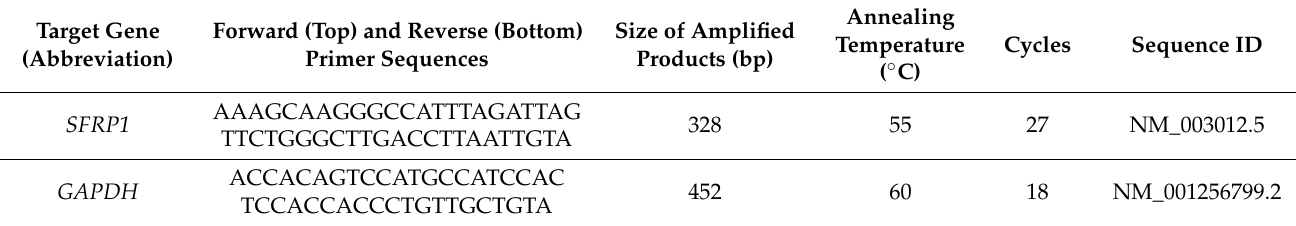
Table 1. Specific primer sequences, annealing temperature, cycle numbers, product sizes, and sequence IDs for semi- quantitative